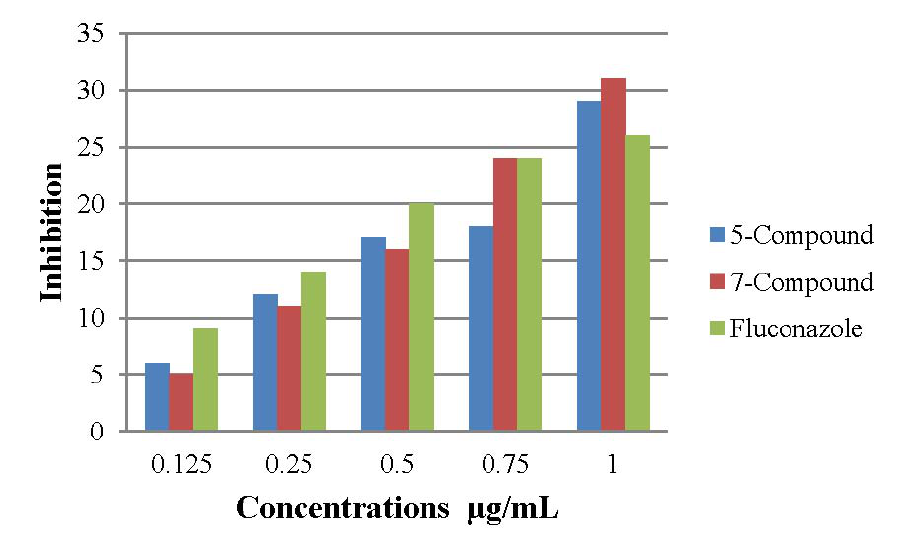
Figure 5. The effect of compounds 5 and 7 toward the tested organism Candida albicans